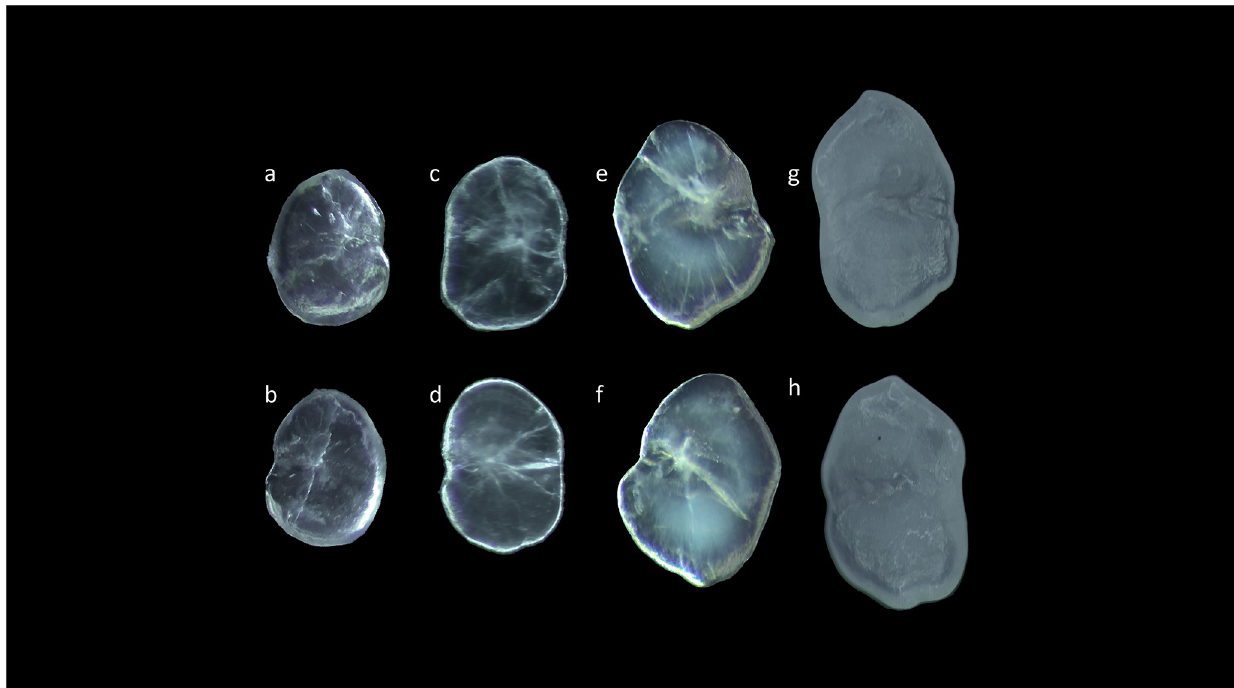
Fig 2. Stereoscope images of left (a,c,e,g) and right (b,d,,f,h) sagittae inner surfaces belonging to size Classes I (a,b), II (c,d), III (e,f) and IV